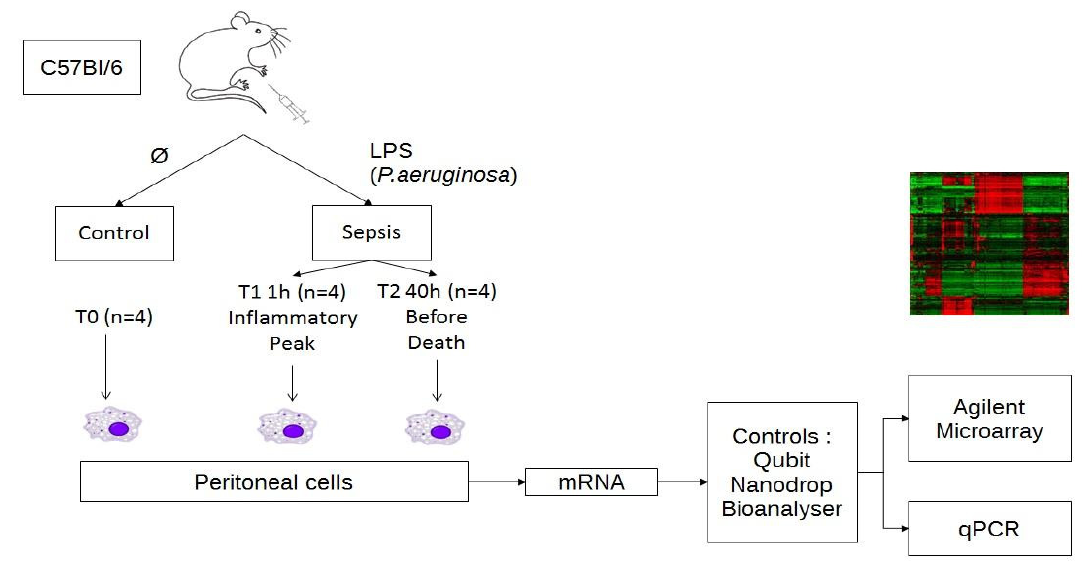
Figure 1. Experimental design and data analysis. Schematic outline representing the experimental design for the microarray analysis in SurePrint G3 8 × 60 K mouse from Agilent. RNA was extracted from the peritoneal cells of 4 mice ( n = 4 for each group) injected in the peritoneal cavity either with PBS or with LPS during the inflammatory peak (T1 = 1 h) and before death (T2 = 40 h). As many as 62,976 probes corresponding to 39,430 coding RNAs and 16,251 LincRNAs were used to detect mRNA expression levels for each RNA sample using a SurePrint G3 Mouse Gene Expression 8 × 60 K v2 Microarray Kit, and the data were analyzed using “AgiND” library loaded into “R” for standardization. Probes with intensity values